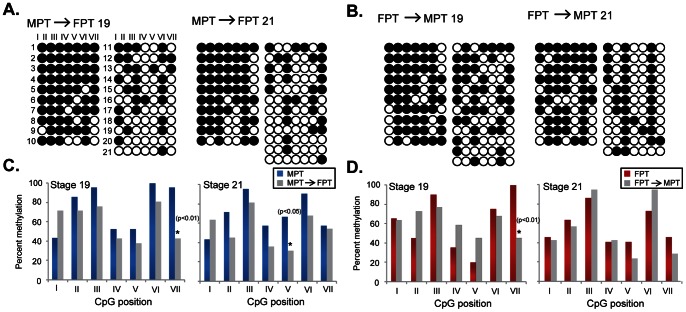
DNA methylation of the putative aromatase promoter at the individual CpG site in temperature-shifted gonads.At embryonic stage 16, eggs are shifted to the opposite temperature, MPT to FPT (A, C) and FPT to MPT (B, D). (A, B) DNA methylation status in clones from the gonads at embryonic stage 19 and 21 after temperature-shift. Each row represents a single clone (1–21∼22 clones/stage/temperature) and a column represents the position of CpG (I – VII). Open circles: unmethylated CpG sites. Closed circles: methylated CpG sites. (C, D) Percent DNA methylation at the individual CpG site (I – VII) of the putative aromatase promoter at stage 19 and 21 in the slider gonad. Asterisk (*) is statistically significant (p<0.05) according to the Fisher's exact test. MPT: male-producing temperature. FPT: female-producing temperature.